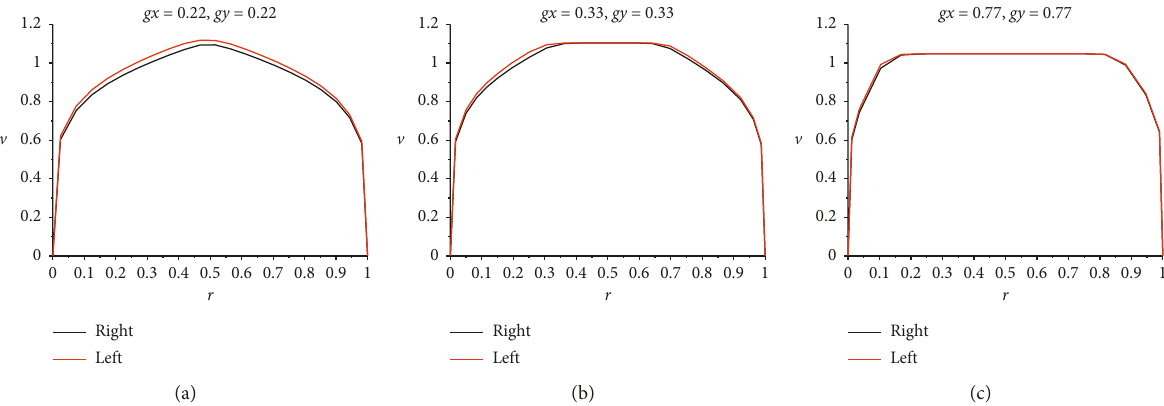
Figure 10: Velocity profile from each side of the cylinder for gx � gy � 0.22 (a), for gx � gy � 0.33 (b), and for gx � gy � 0.77